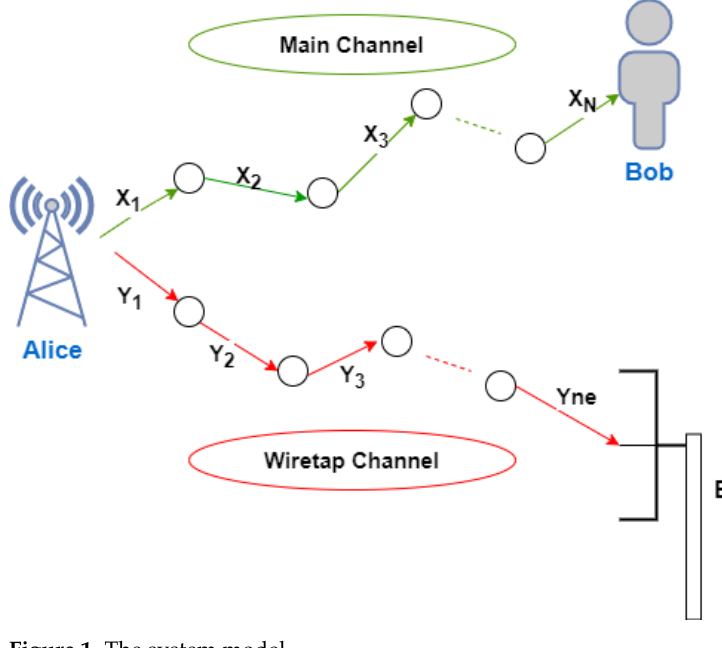
Figure 1. The system